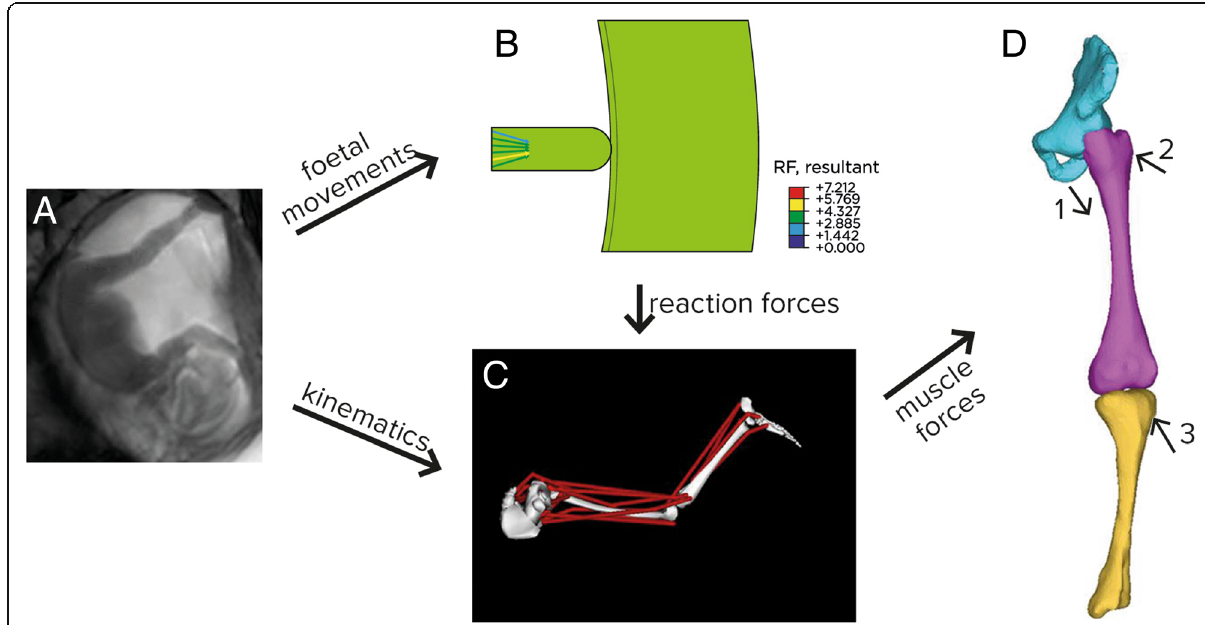
Fig. 5 Computational pipeline for developing stress modelling of foetal movements. Foetal joint movements are tracked in utero ( a ), with finite element modelling of reaction forces ( b ) combined with musculoskeletal modelling to predict muscle forces ( c ) which are then applied to finite element models of foetal geometries ( d ). Adapted from [21]